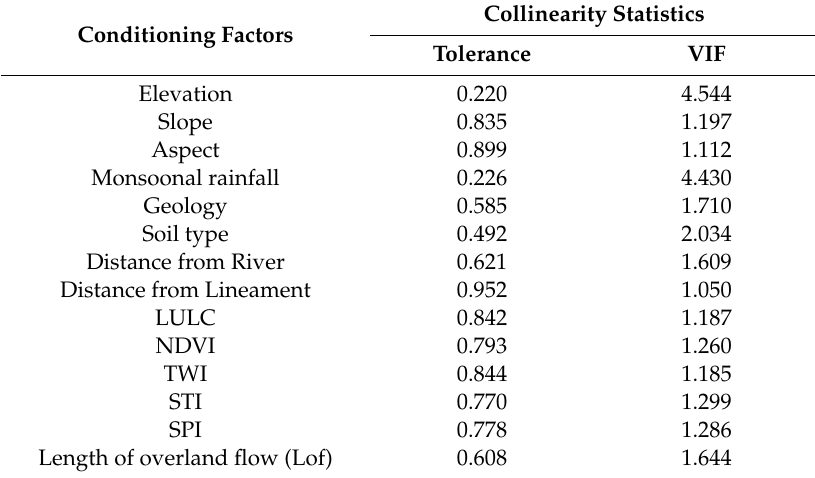
Table 2. Multi-collinearity analysis of the gully conditioning